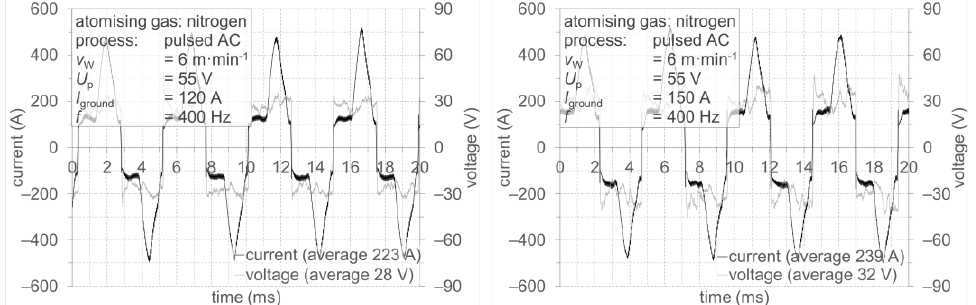
Figure 17. Current/voltage curve, pulsed alternating current, ( left ): I ground = 120 A, ( right ): I ground = 150 A.